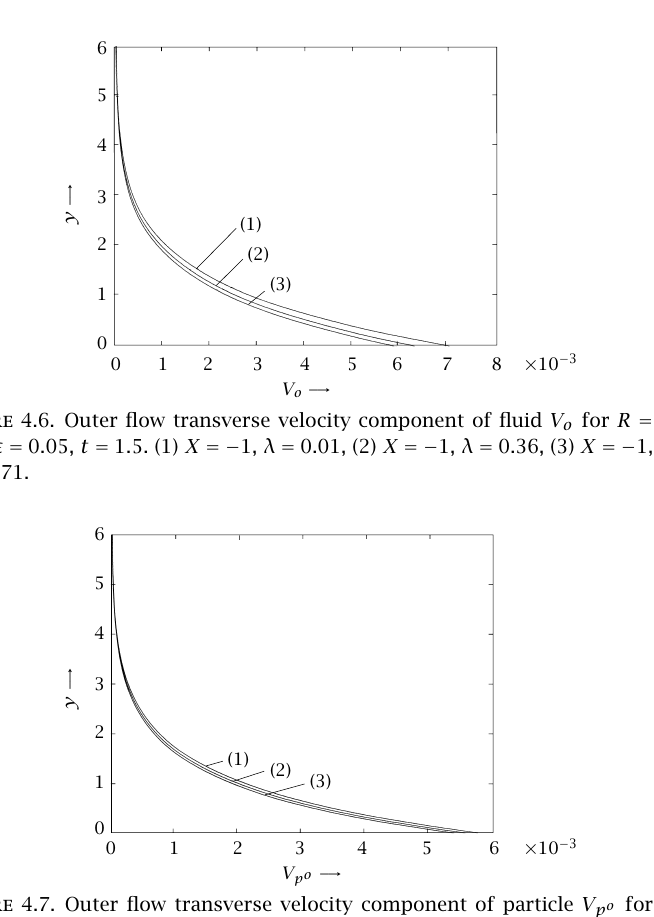
Figure 4.5 . Outer flow transverse velocity component of fluid V o for R = 500, 4 = 0 . 05, t = 1. (1) X = − 1, λ = 0 . 01, (2) X = − 1, λ = 0 . 16, (3) X = − 1, λ = 0 . 31, (4) X = 1, λ = 0 . 01, (5) X = 1, λ = 0 . 16, (6) X = 1, λ = 0 . 31.